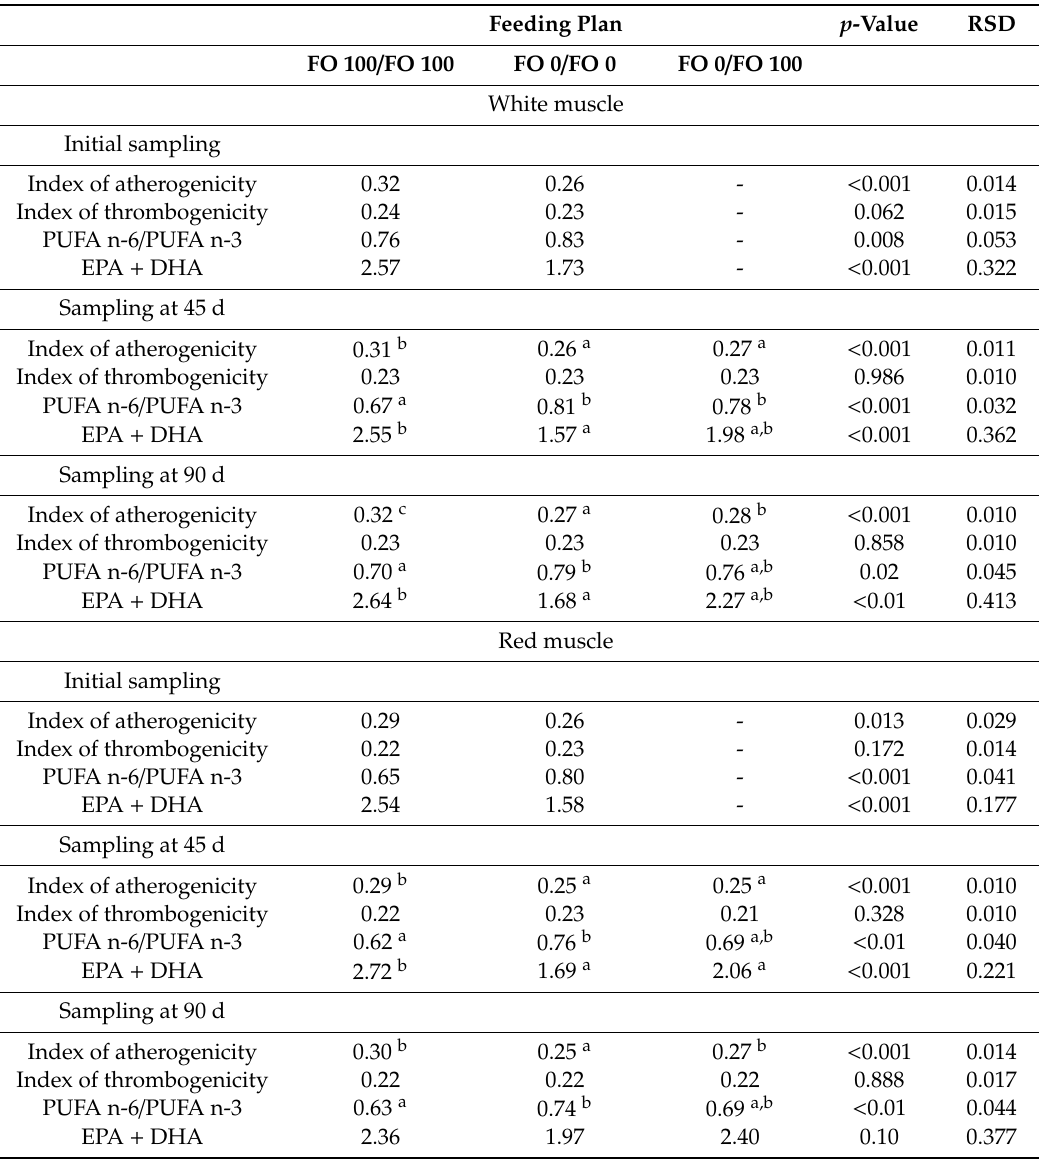
Table 5. Indices of nutritional quality of lipids and EPA + DHA content (g / 100 g of muscle) of white and red muscles in S. dumerili at the beginning of the wash-out period (0 d) and after 45 and 90 d: e ff ect of the feeding plan. Values are expressed as least square (LS)